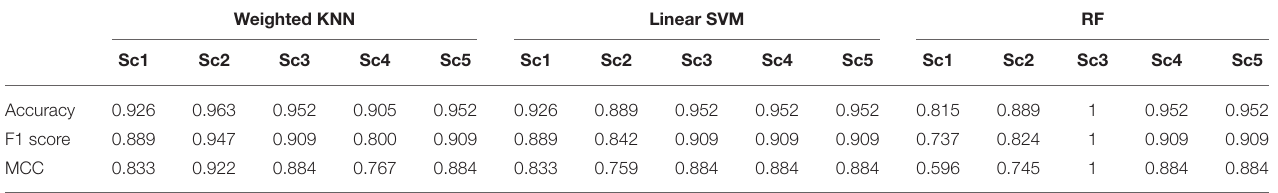
Sc1-Sc5 corresponds to the FV Scenario 1-Scenario 5 of Table 3 ,